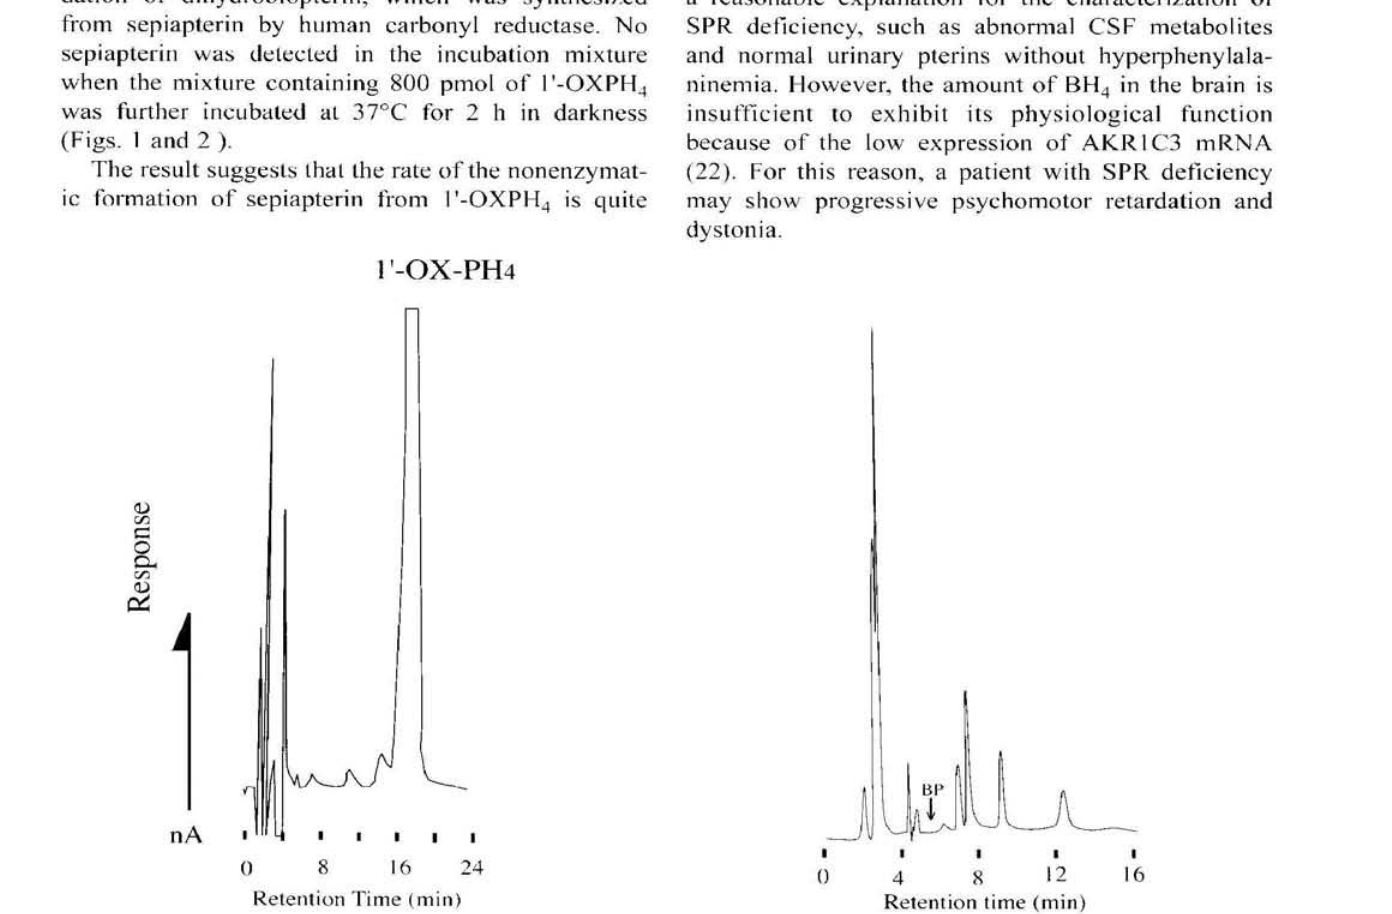
Figure 2. The noncnzymatic formation of sepiapterin from Γ-ΟΧΡΗ4. !'-OXPH 4 (8 μΜ) was initially pro- duced by incubation with PPH 4 and CR I in the absence of dithiothreitol in a final volume of 100 μΐ, and the reaction mixture was incubated at 37°C for 2 h in darkness. Human monomeric carbonyl reductase was added to the reaction mixture and further incubat- ed at 37°C for 40 min. The reaction was stopped by the addition of 10 μΐ of a 20% trichloroacetic acid solution and 20 μΐ of an iodine solution (1% I 2 , 2% Kl). The amount of biopterin in the resulting supernatant